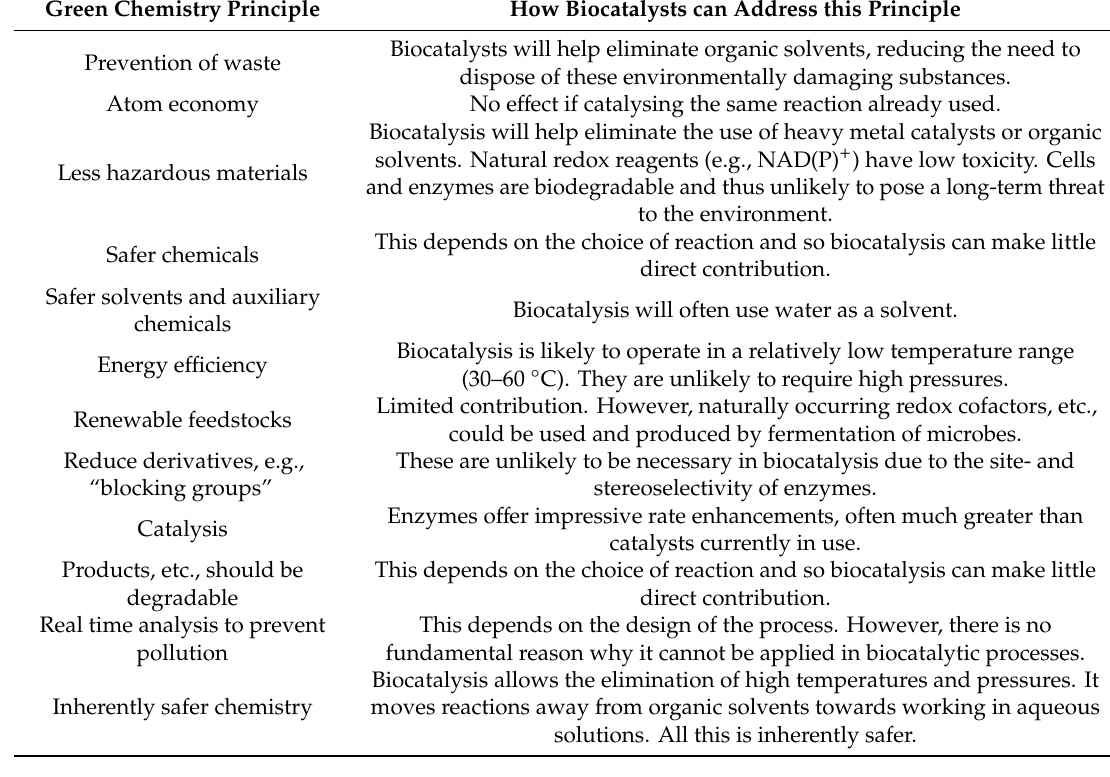
Table 1. Biocatalysis and the twelve principles of green